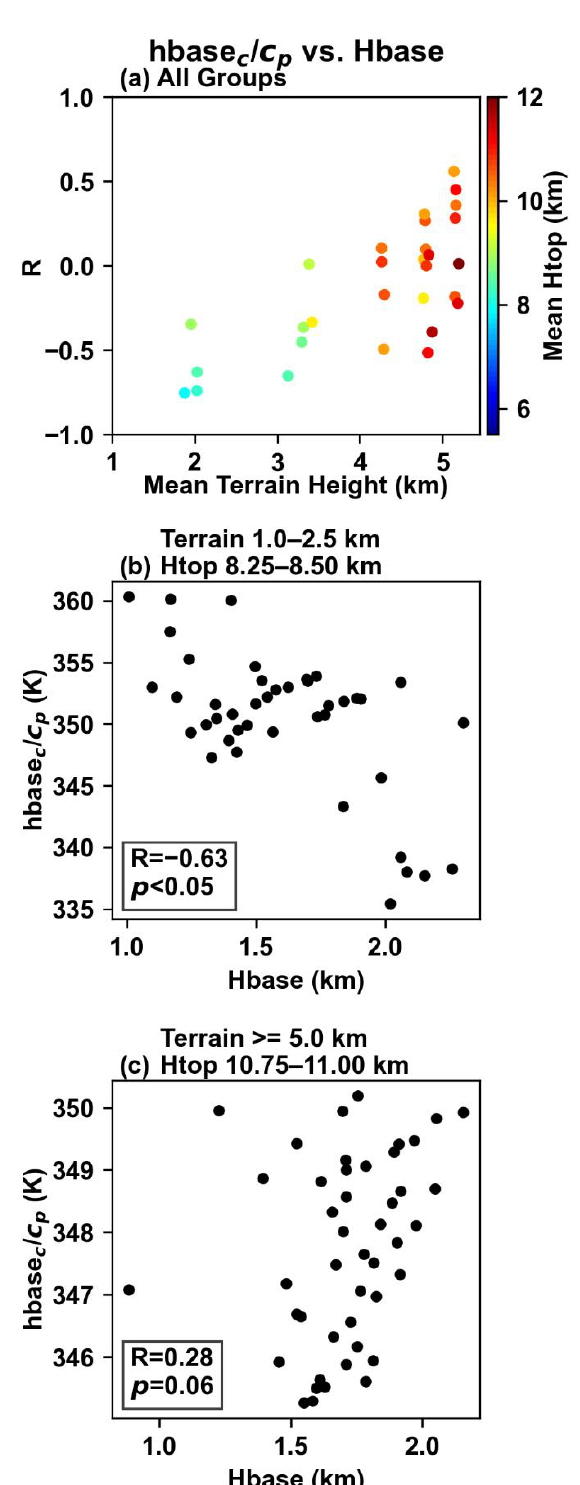
Figure 7. The correlation coefficients (R) of cloud base in-cloud moist static energy (represented by hbase c / c p ; units: K; c p is the isobaric specific heat of dry air) and cloud base height above the surface (Hbase; units: km) in the different cloud groups above 1 km terrain height (Panel a ), and the relationship between the hbase c / c p and Hbase in the representative cloud groups (Panels b , c ); the color bar denotes the mean cloud top height in each group.